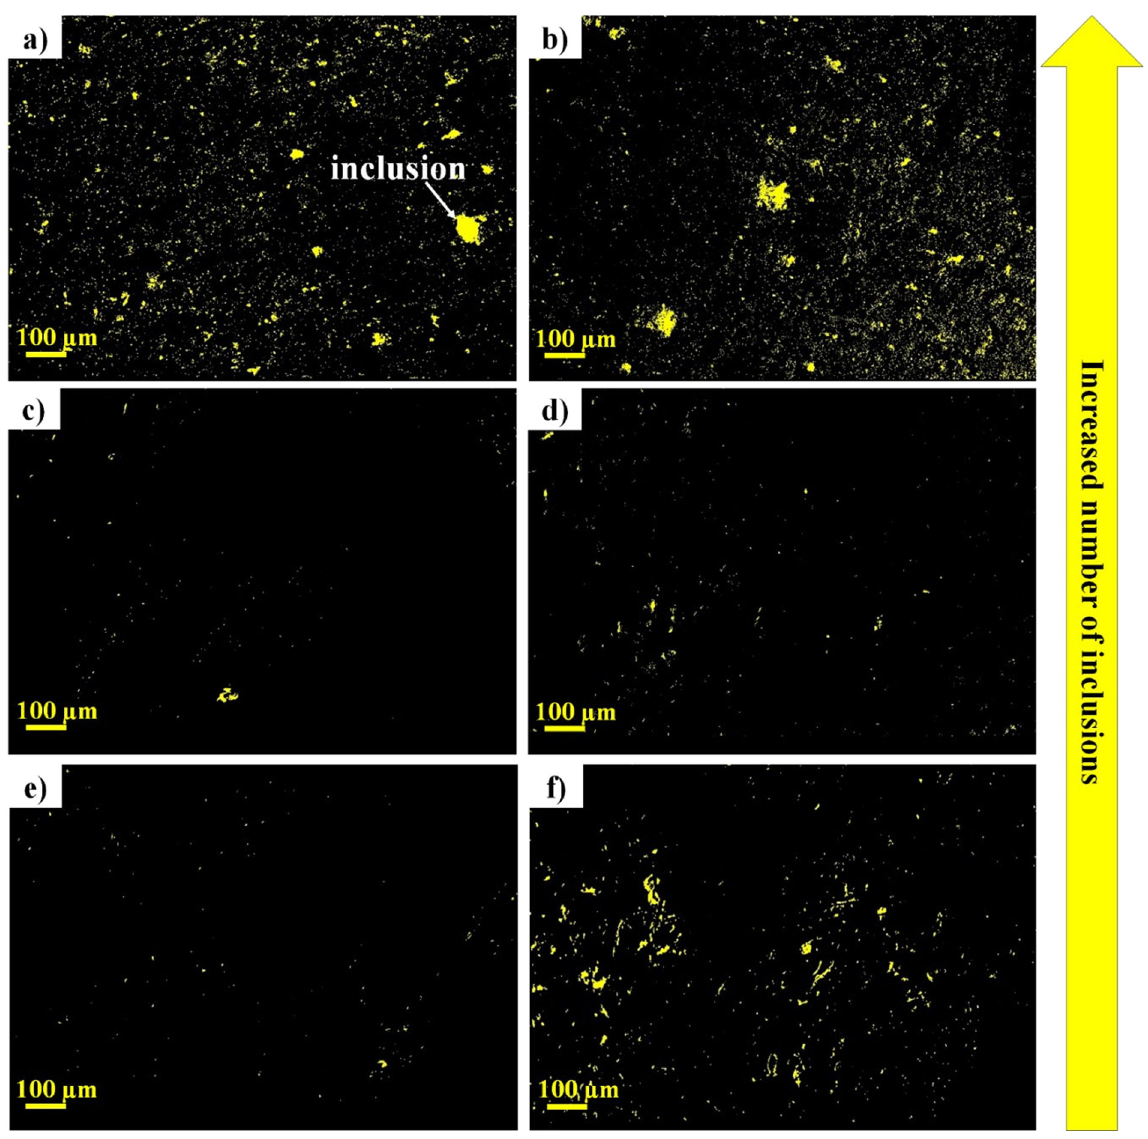
Fig. 5 Image analysis of SEM images of samples #4 at region 1 before and after storage. a , b Torre fi ed pellet (tor_sample4) before storage ( a ) and after 1 month of storage ( b ). c , d Wood pellet type I (wp1_sample4) before storage ( c ) and after 1 month of storage ( d ). e , f Wood pellet type II (wp2_sample4) before storage ( e ) and after 1 month of storage ( f ). Yellow colour indicates the inclusions detected at the surface of the